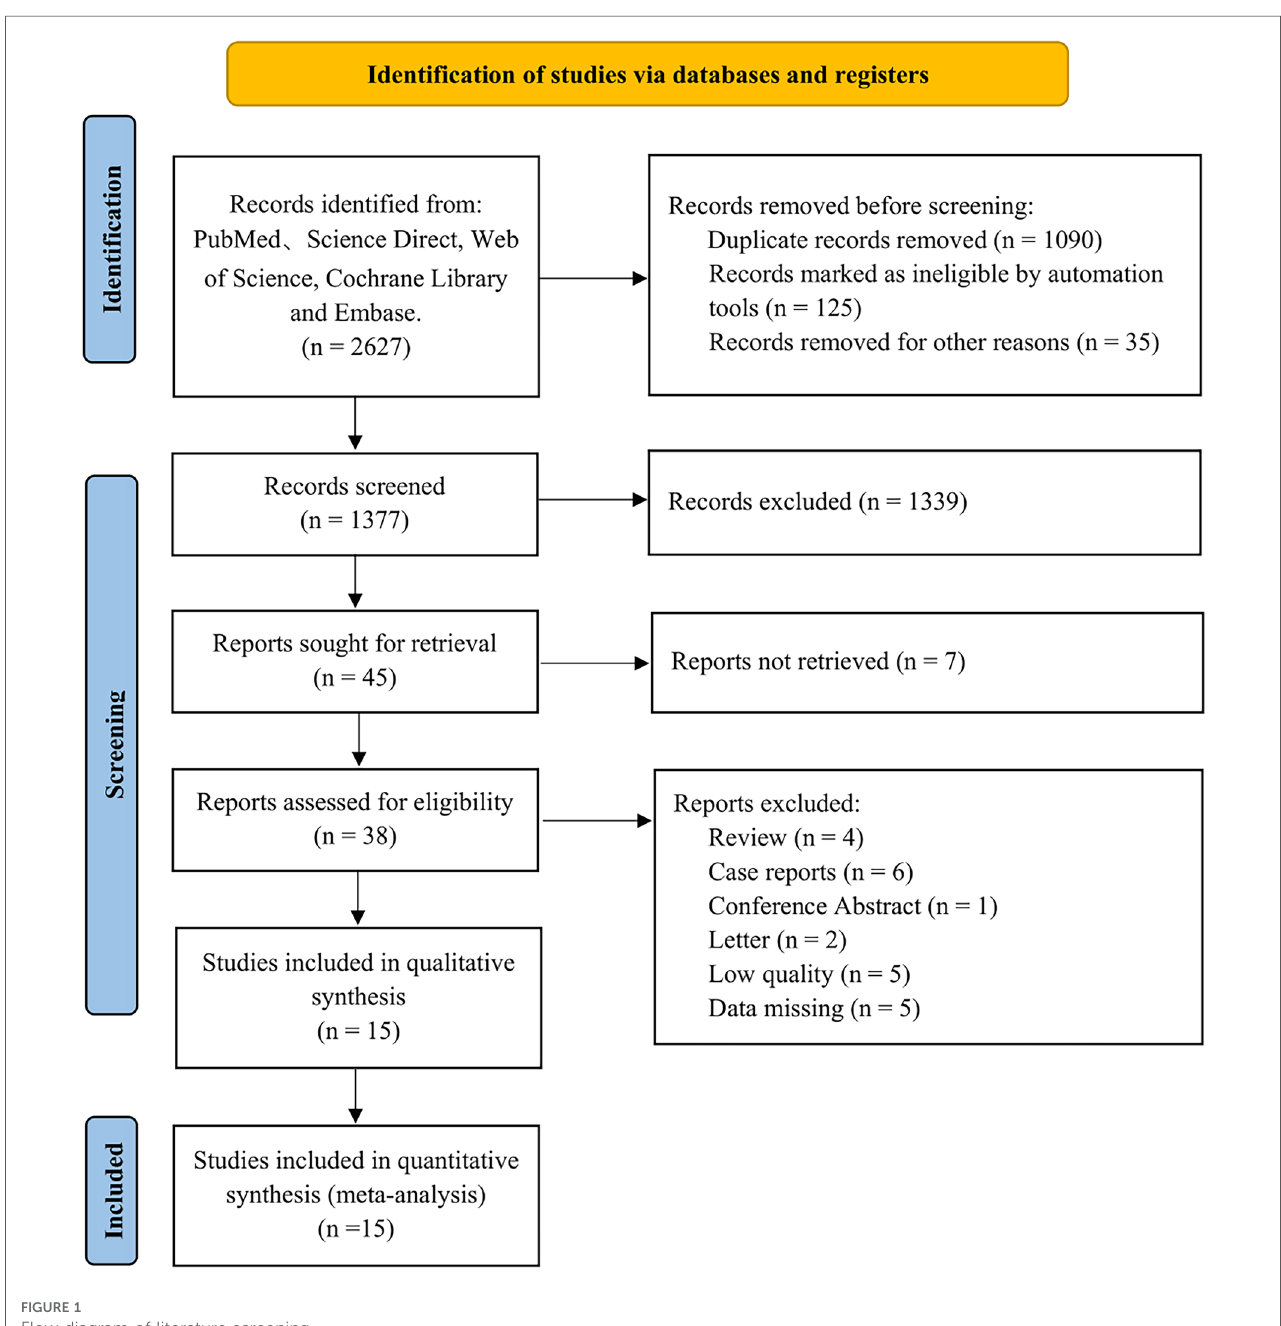
FIGURE 1 Flow diagram of literature